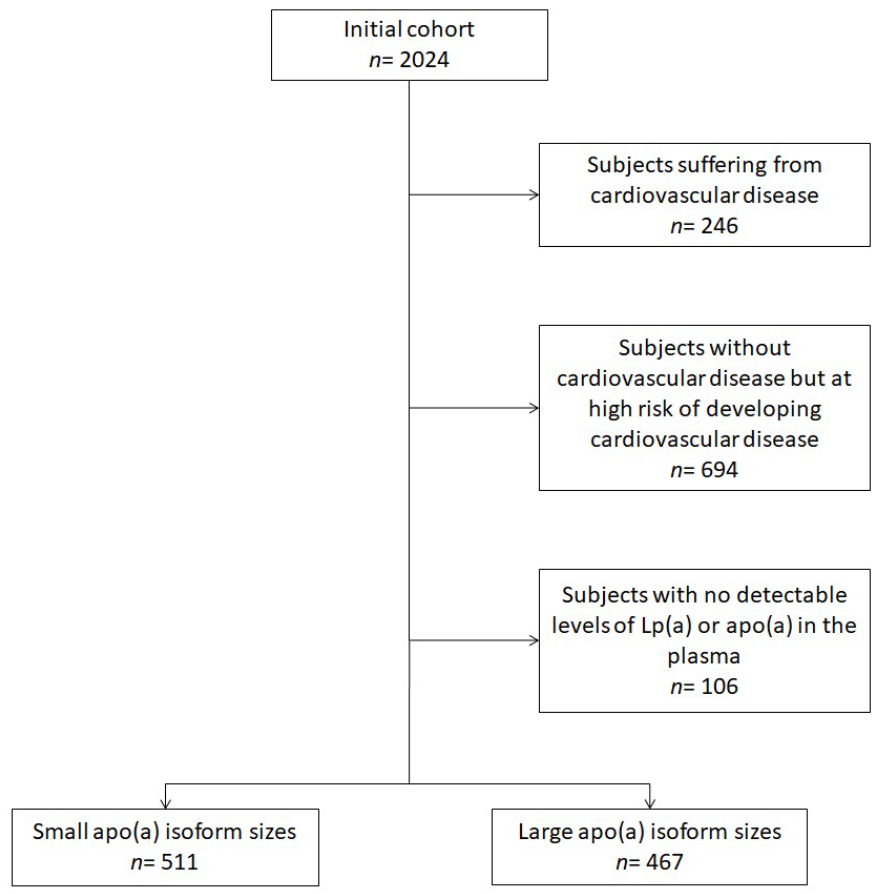
Figure 1. Flow-chart resuming the selection criteria applied to the full BHS cohort to select the sub-cohort.